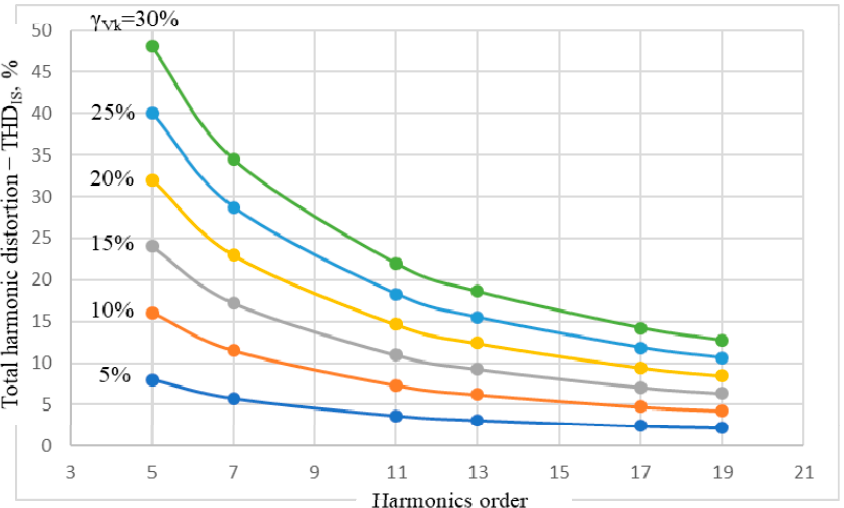
Figure 4. THD IS dependence on the k-order and the weight γ Vk of the voltage harmonics.